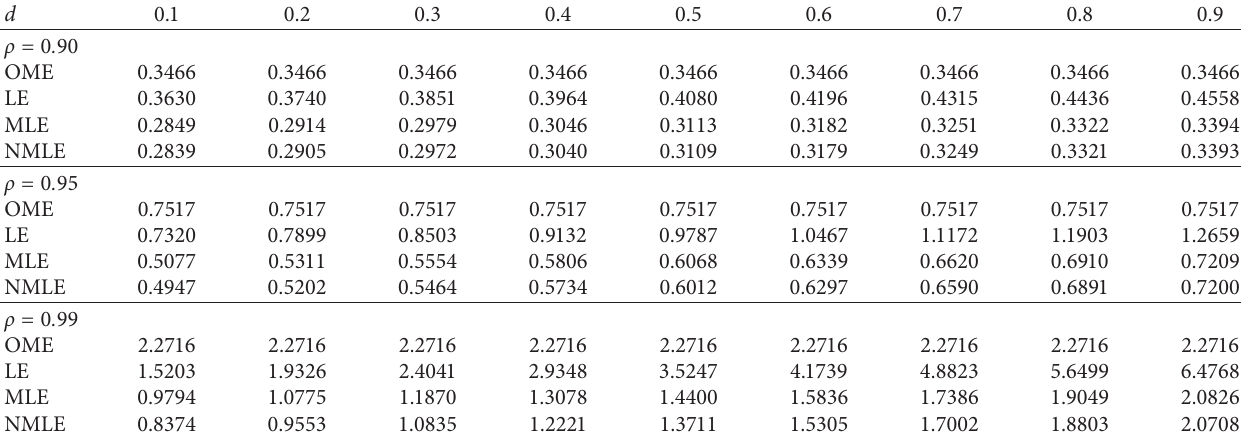
Table 1: MSE values of the estimator for different values of d and ρ when σ � 1 and n � 50.